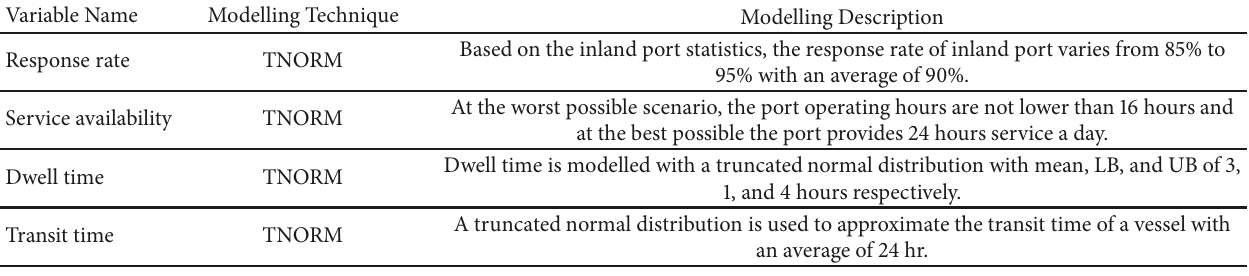
Table 7: NPTs of the variables describing response rate, service availability, dwell time, and transit time.